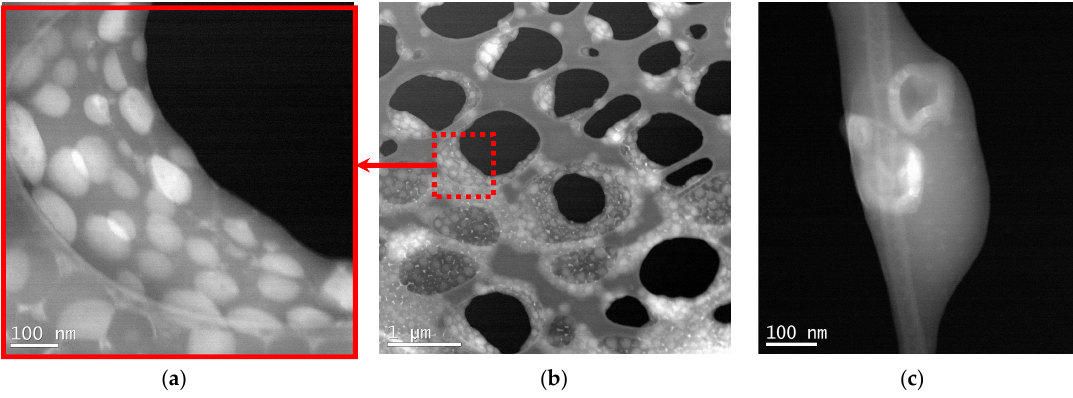
Figure 7. Structure of hybrid dispersion particles settled on the micromesh net as determined by transmission electron microscopy (TEM): ( a ) SIL-ACR dispersion, higher magnification, ( b ) SIL-ACR dispersion, lower magnification, ( c ) ACR-SIL dispersion, higher magnification. Lighter shade represents silicone resin and darker shade–acrylic/styrene copolymer.